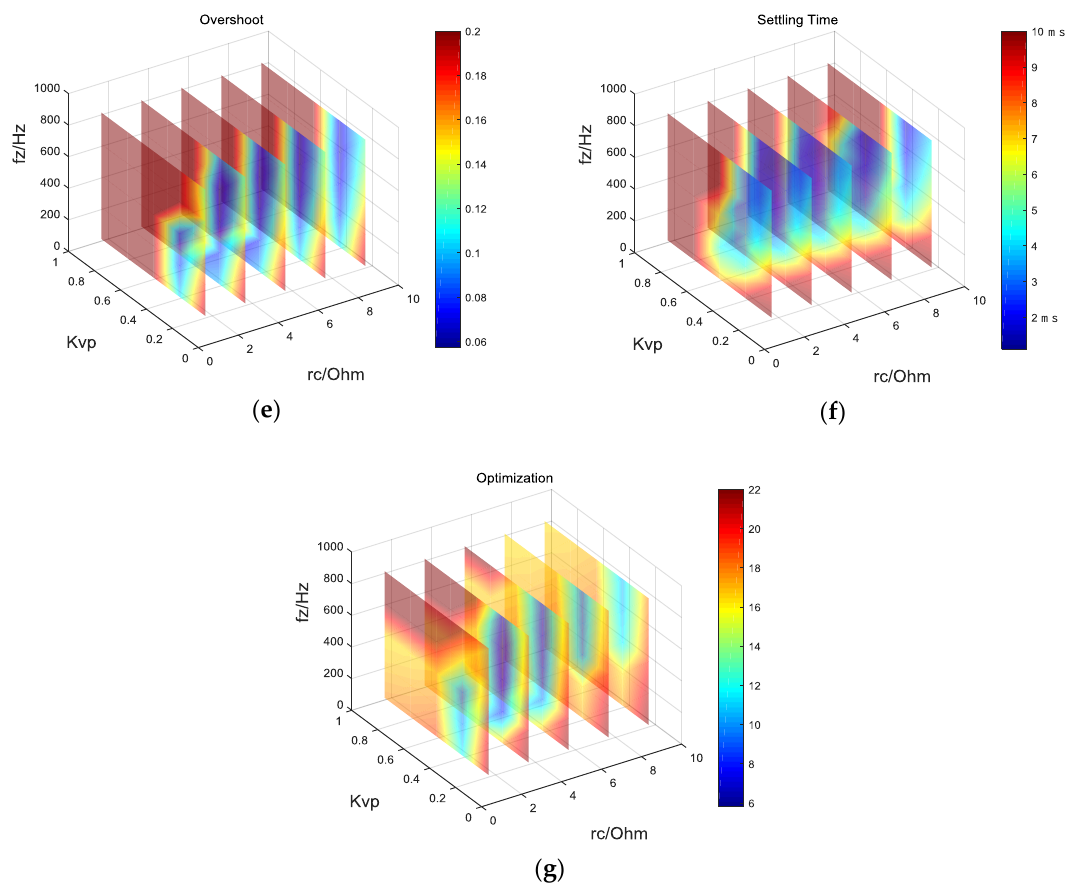
Figure 15. The results of numerical calculation: ( a ) the gain of the resonance peak; ( b ) the minimum of the concave part; ( c ) difference between the gain of the resonance peak and the minimum of the concave part; ( d ) stability; ( e ) overshoot; ( f ) settling time; ( g ) the result of the optimum design.